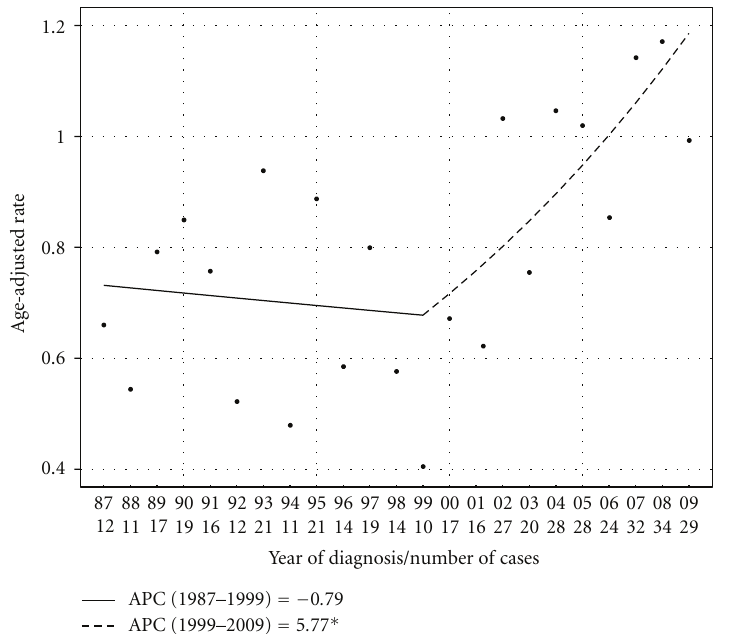
Figure 1: Age-adjusted incidence rates (in cases per million persons per year) with Joinpoint regression trendlines for all patients with MMHN in SEER 9 registries from 1987 to 2009. The APC over this time period was 2.4%.